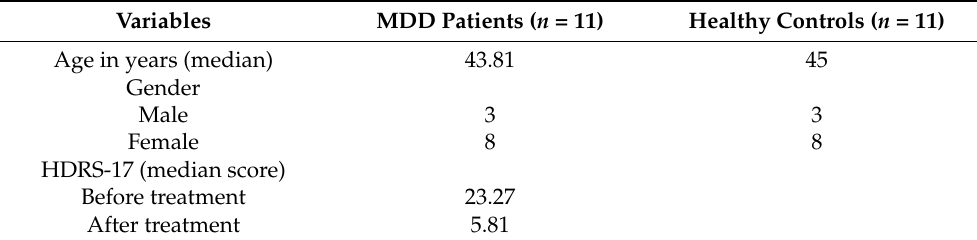
Table 6. Characteristics of MDD patients and controls enrolled in the study.